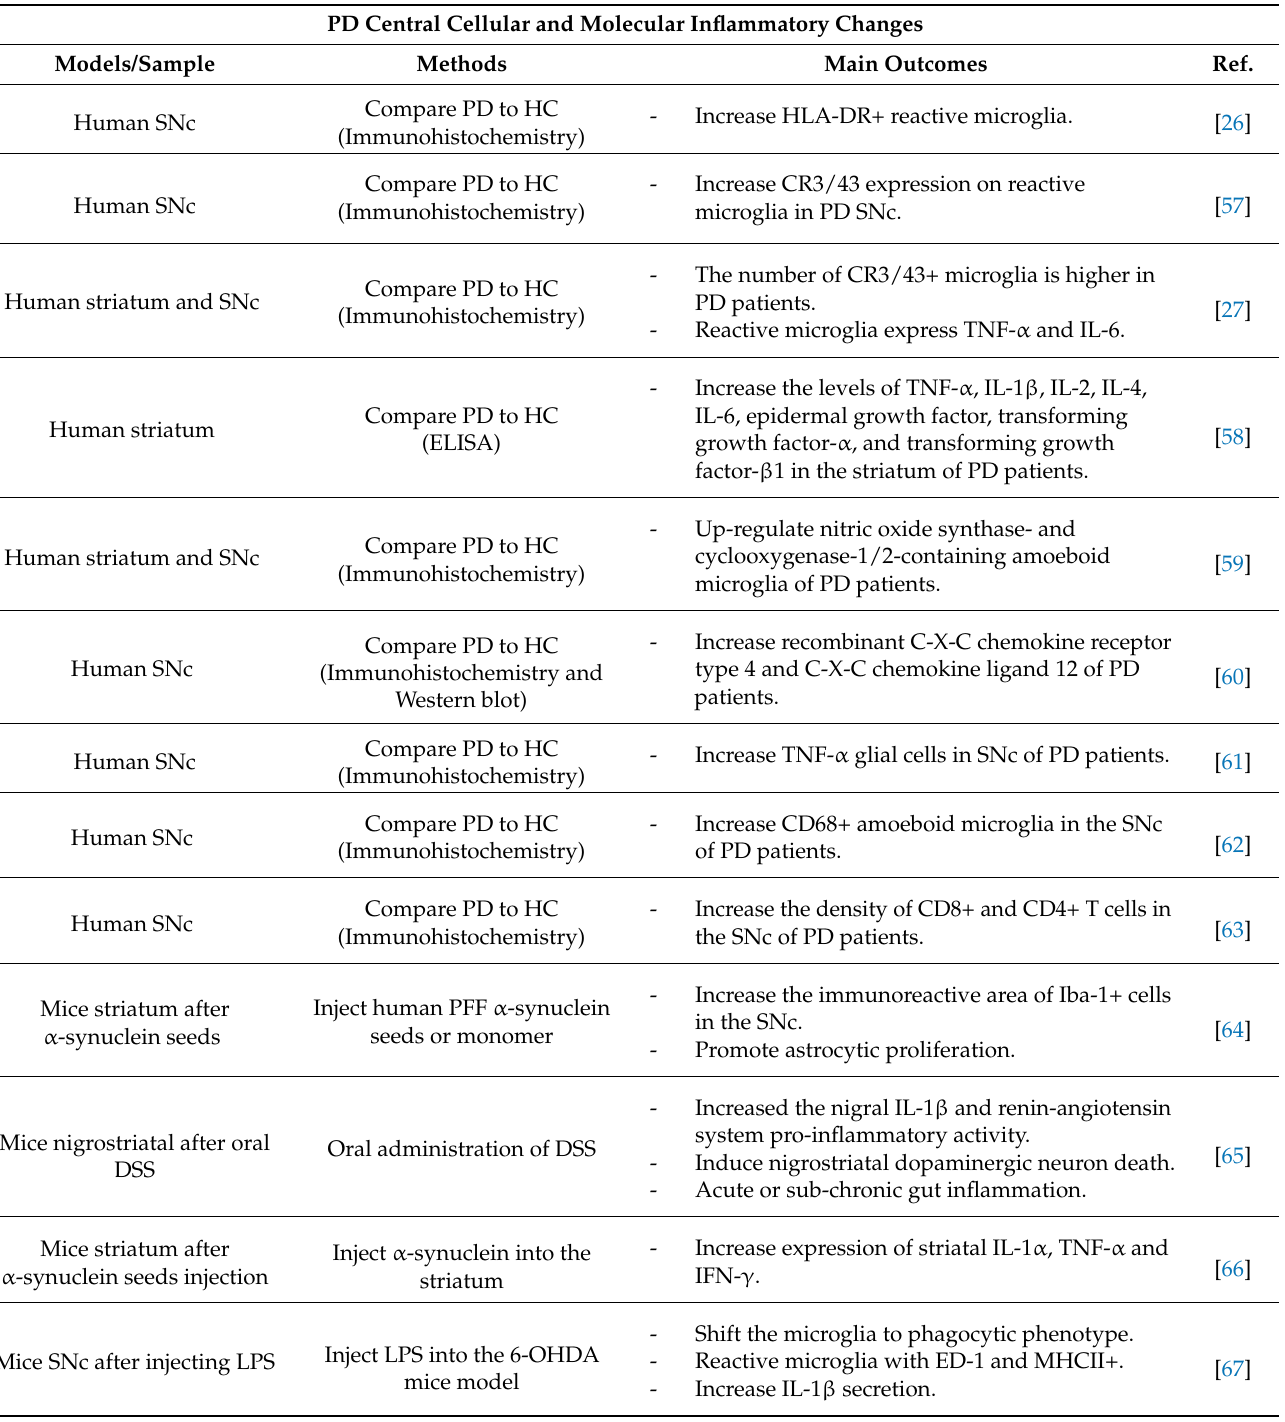
Table 1. Central and peripheral inflammatory changes (cellular and molecular) in